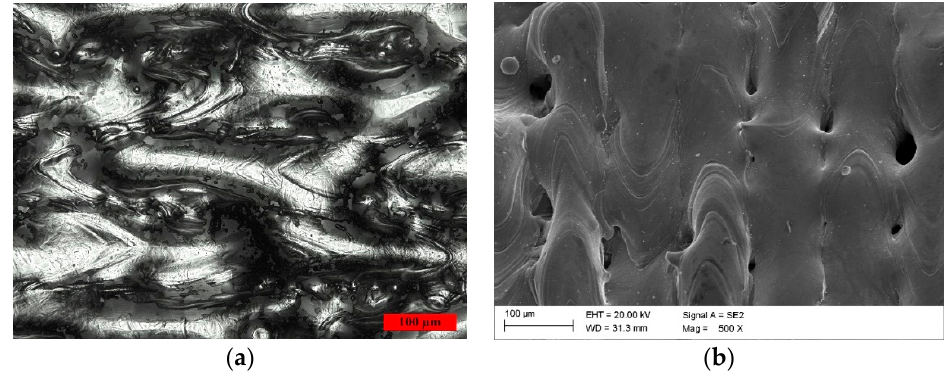
Figure 20. The surface structure of Ti6Al4V Ti solid 5 alloy specimen made ( a ) on a light microscope and ( b ) on an SEM.